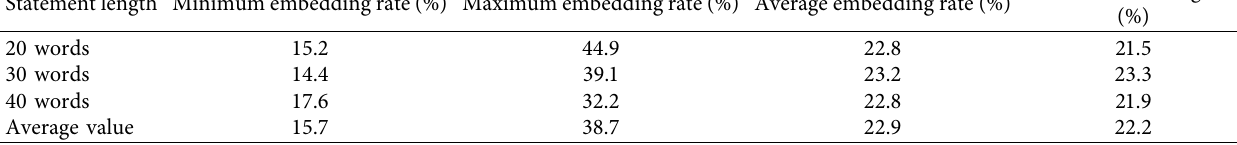
Table 3: Comparison of embedding rates of sentences with different word